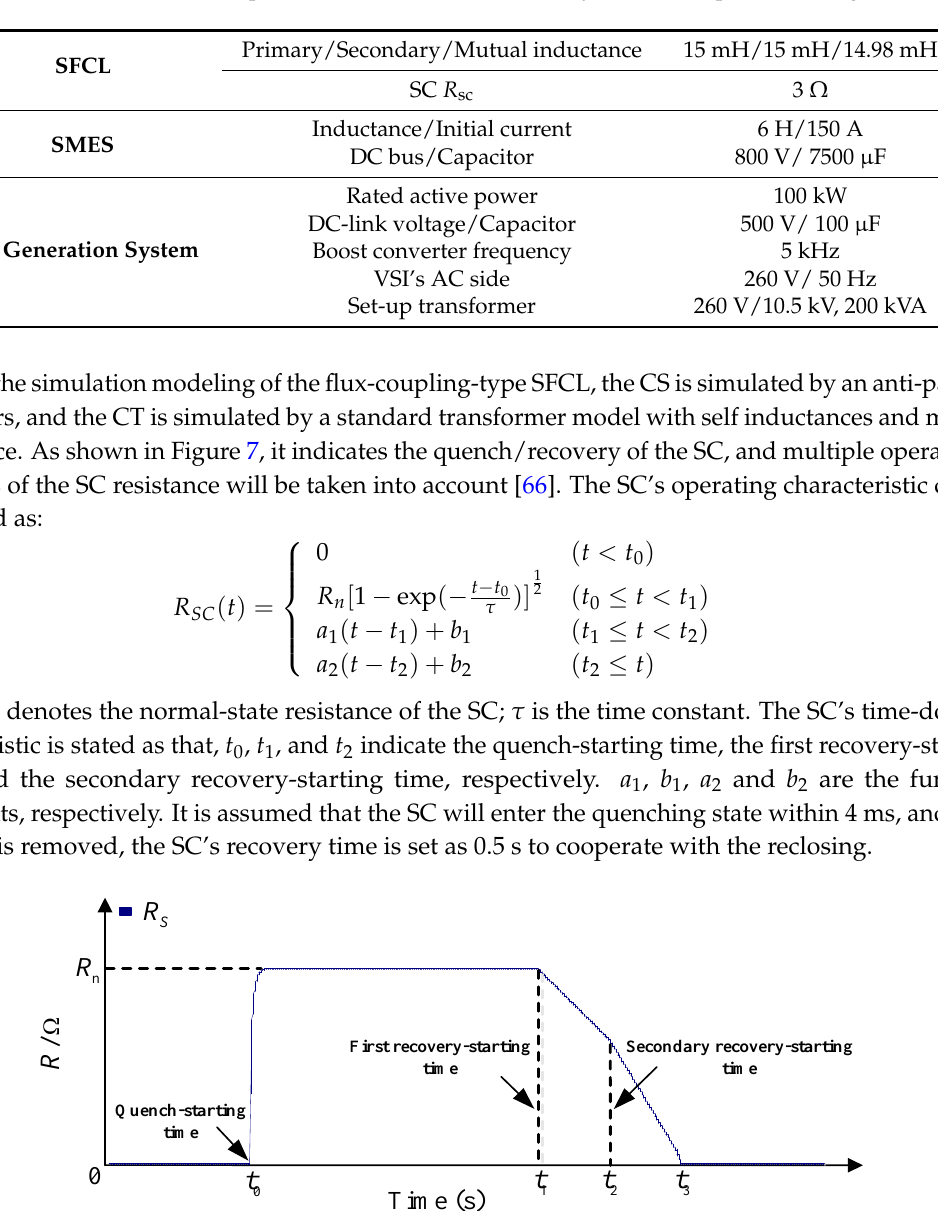
Table 1. Main simulation parameters of the demonstrated system. SC: superconducting coil. SFCL